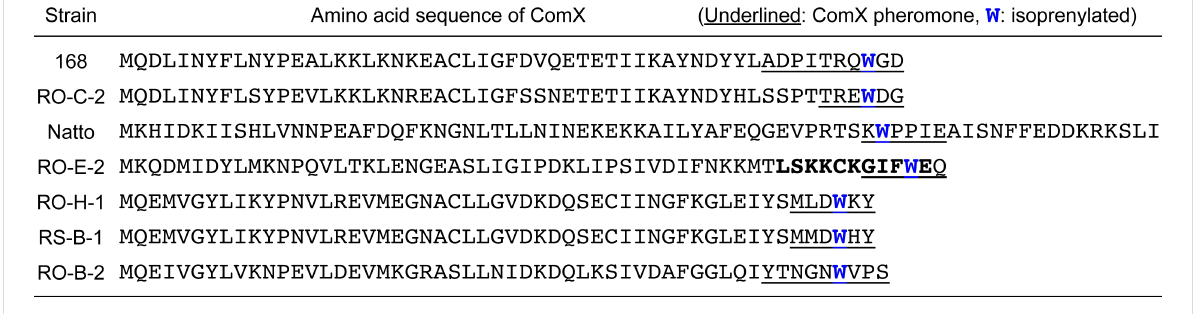
Figure 5: Amino acid sequences of ComX from seven Bacillus strains. The sequences of the mature pheromones are underlined, and the isopreny- lated tryptophan residues are shown in bold and colored blue.